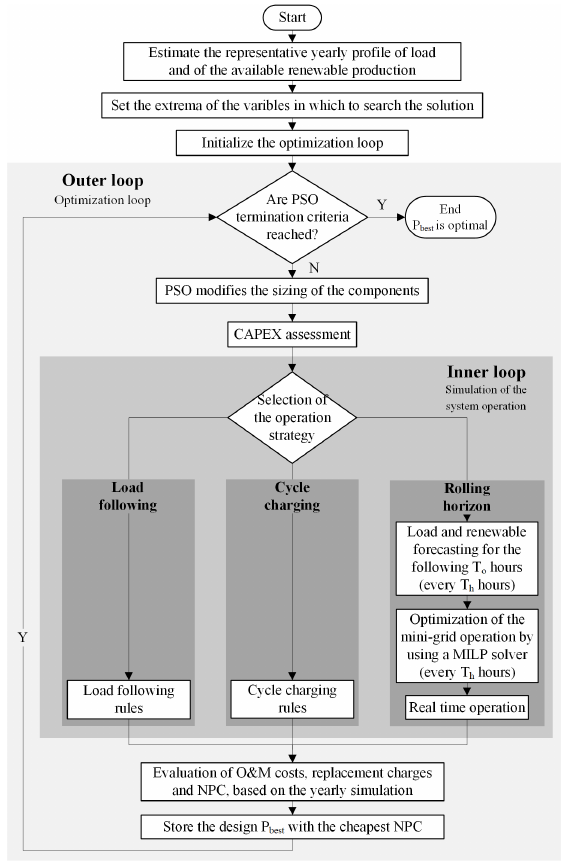
Figure 1. Algorithm of the proposed heuristic-based